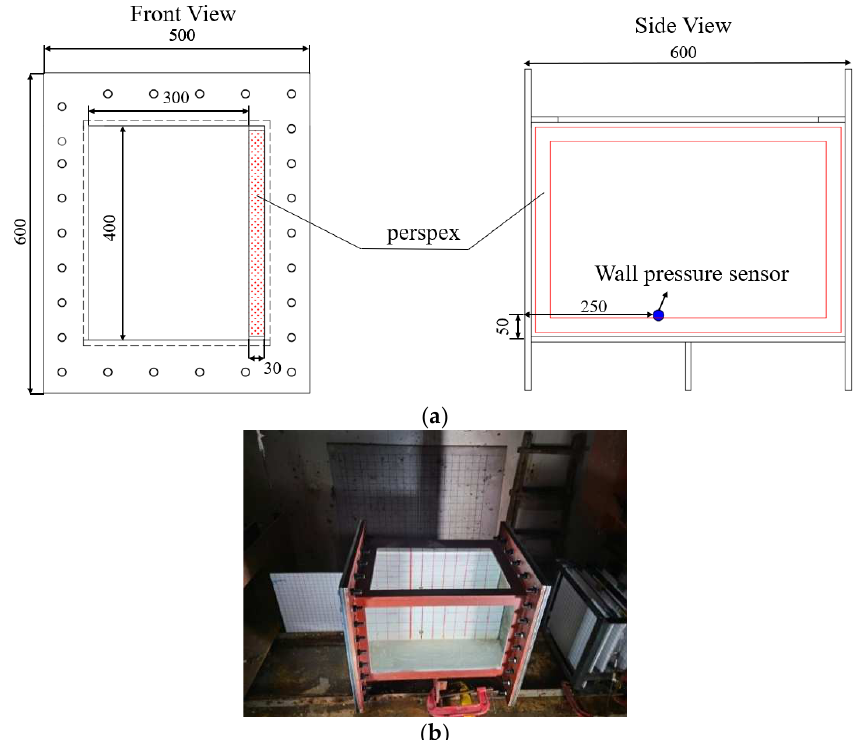
Figure 1. Diagram and photo of the water tank model. ( a ) Diagram of water tank model. ( b ) Water tank